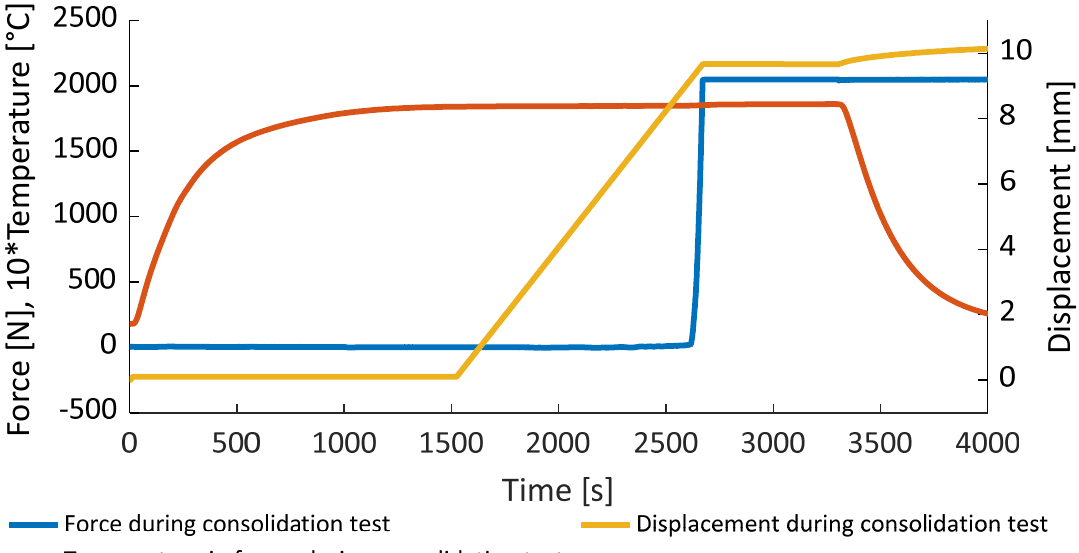
Figure 6. Force, temperature, and mold’s displacement measured during experiments.